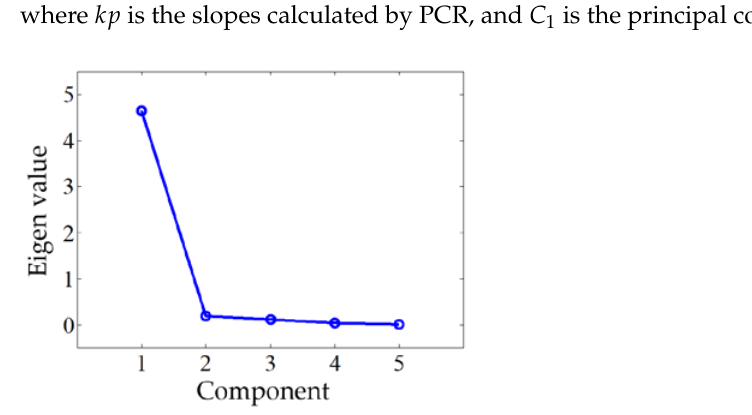
Table 11. Total variance explained.